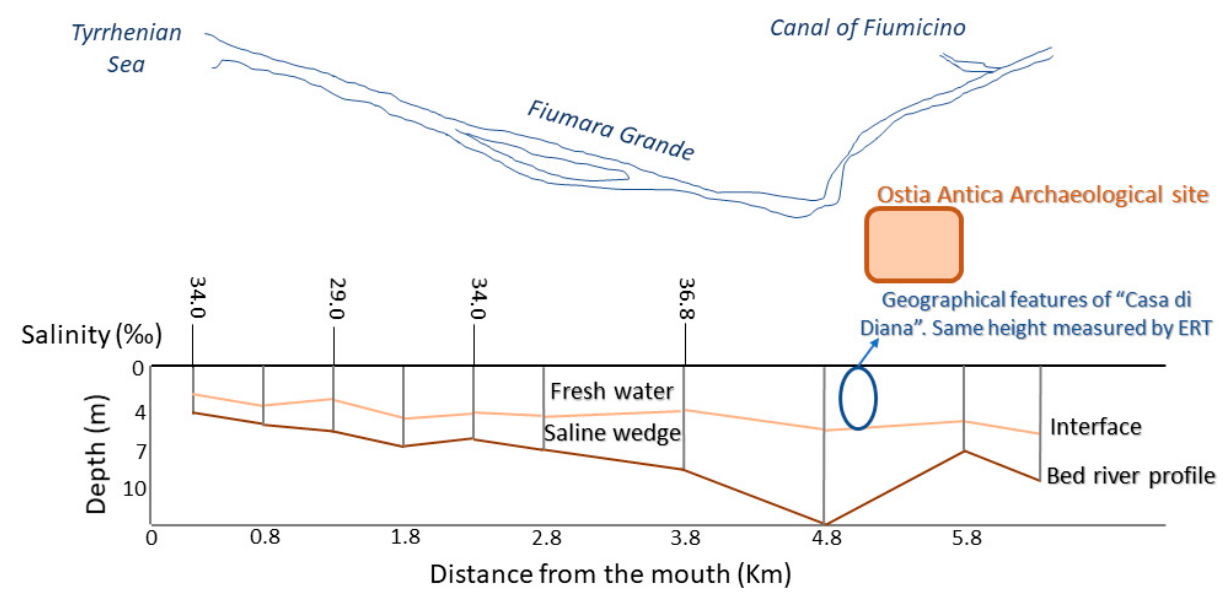
Figure 6. Schematic cross-section of the saline intrusion and the bathymetry along the median axis of the “Canale della Fiumara Grande”, from Capo Due Rami to the river mouth [71]. The cross and the circle indicate the Ostia Antica site and “Casa di Diana” building (with the ERT measurements), respectively.